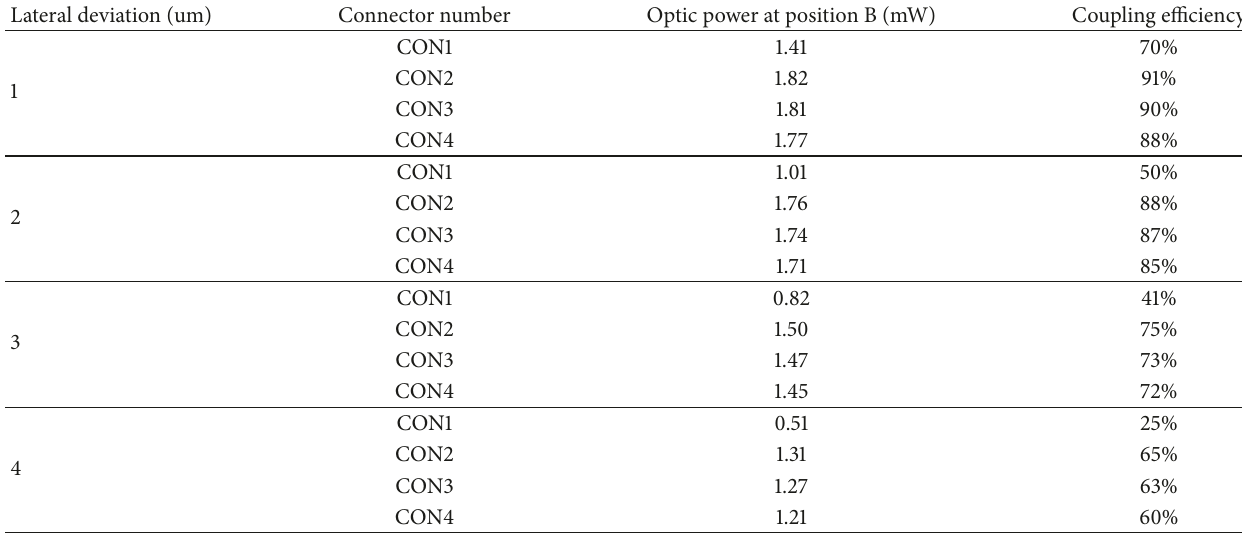
Table 1: The coupling efficiency of both the tapered connectors and common connector.